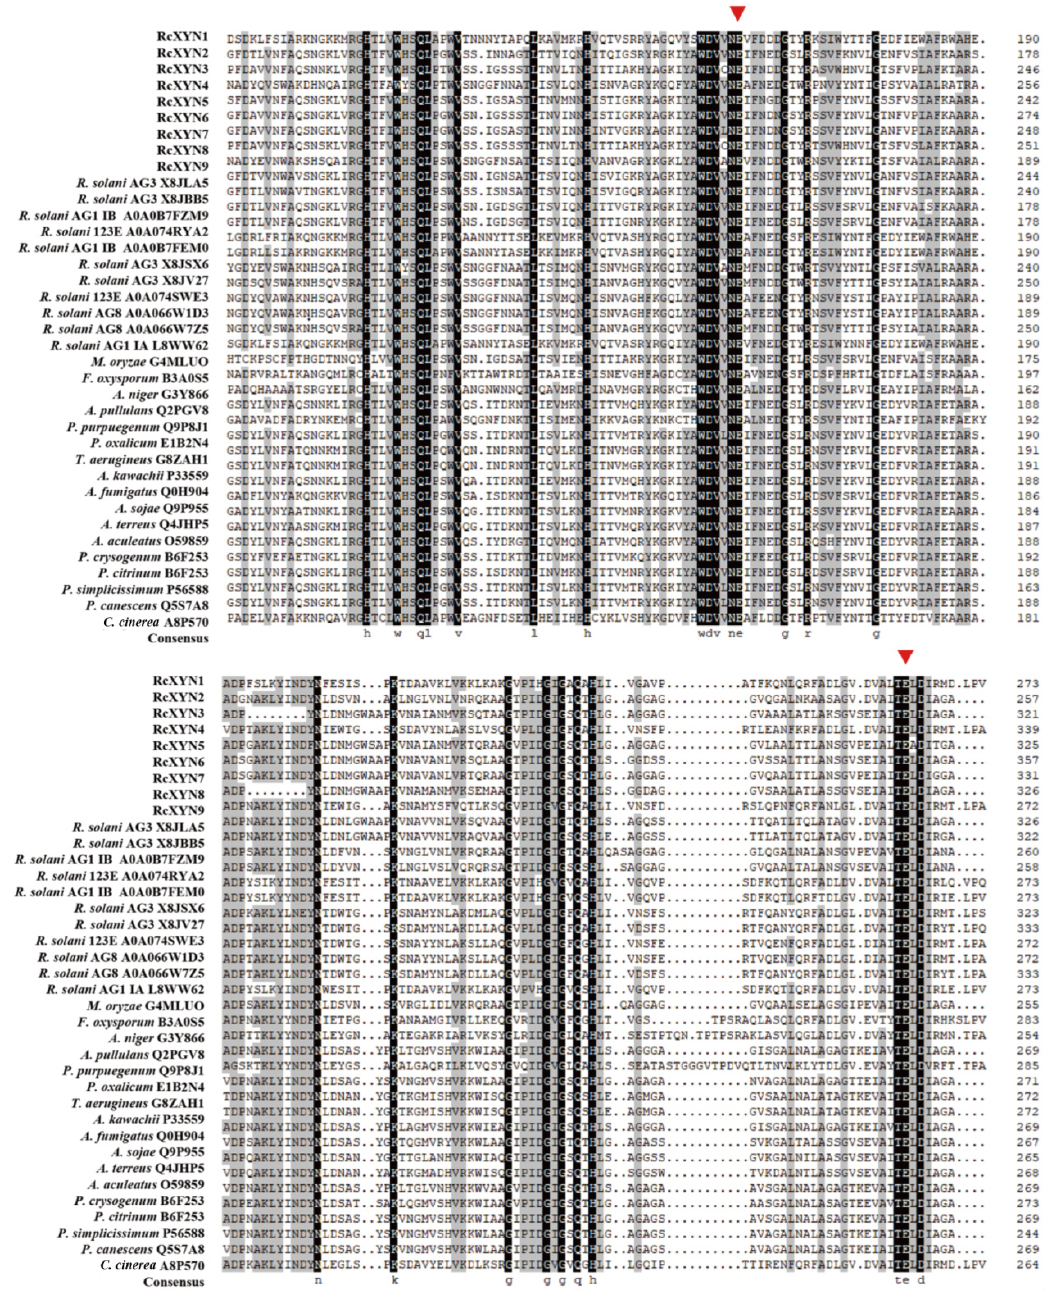
Figure 2. Alignment of amino acid sequences of the active site regions of the 37 GH10 family xylanases. Among them, there were nine GH10 xylanases from R. cerealis , 11 GH10 xylanases from Rhizoctonia solani (123E, AG1 IA, AG1 IB, AG2-2IIIB AG3, AG8), and 17 GH10 xylanases from 17 other fungi ( Magnaporthe oryzae, Fusarium oxysporum, Aspergillus niger, Aureobasidium pullulans, Penicillium purpurogenum, Penicillium oxalicum, Talaromyces aerugineus, Aspergillus kawachii, Aspergillus